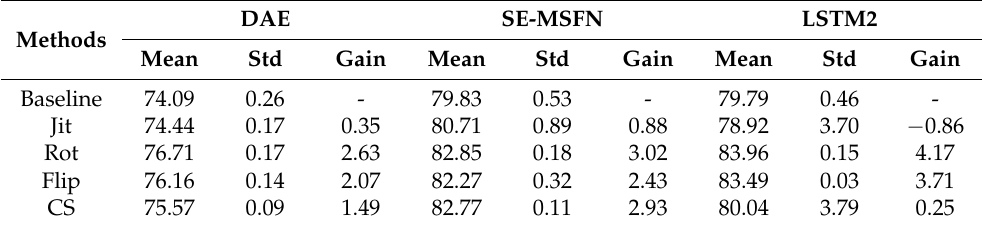
Table 4. The average recognition accuracy (%) of the baseline models on the 2016A-1 dataset using various data augmentation methods and the gain (%) when compared to no data augmentation. The top1 average accuracy and gain have been